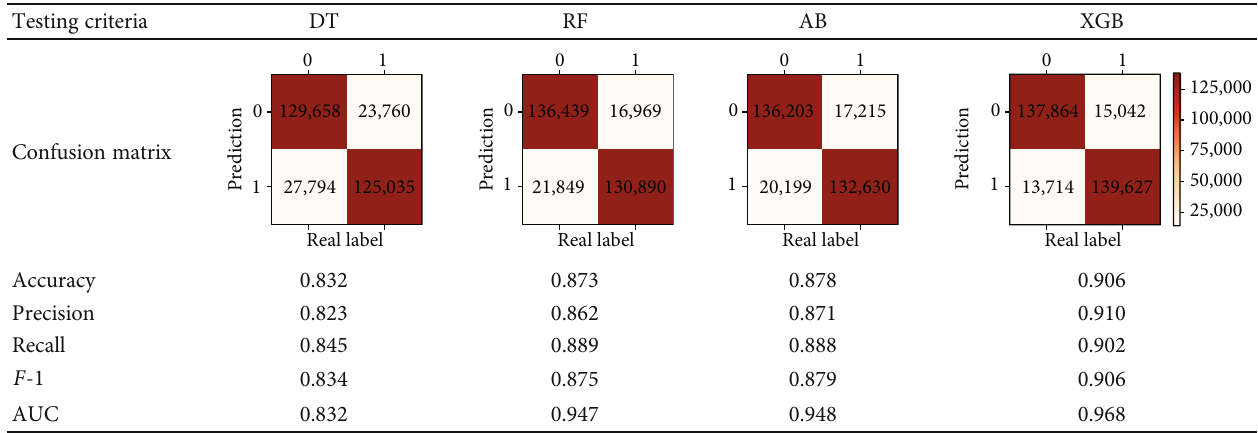
Table 4: The results of classi fi cation algorithms.